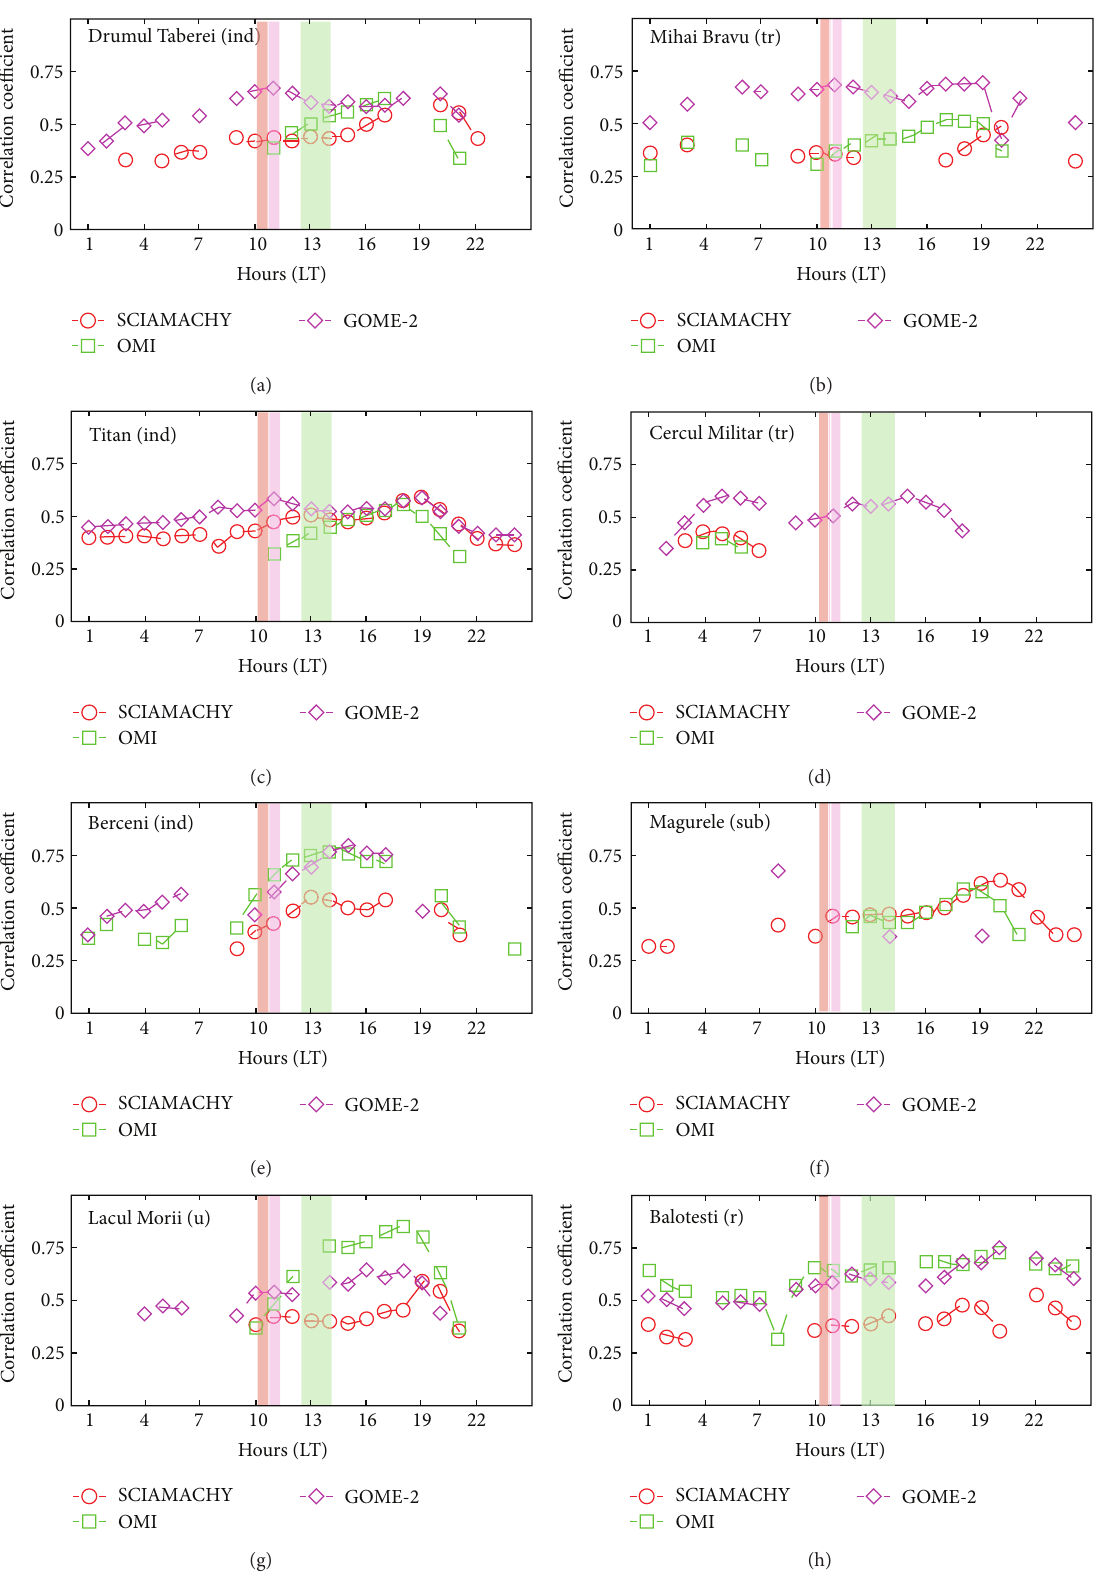
Figure 8: Diurnal variation of significant correlation ( 𝑃 < 0.05 ) between local, in situ, measurements and corresponding satellite records. Coloured rectangles point to the local time when the satellites pass over Bucharest: SCIAMACHY (light red) and GOME-2 at 11LT (light magenta) and OMI at 13LT (light